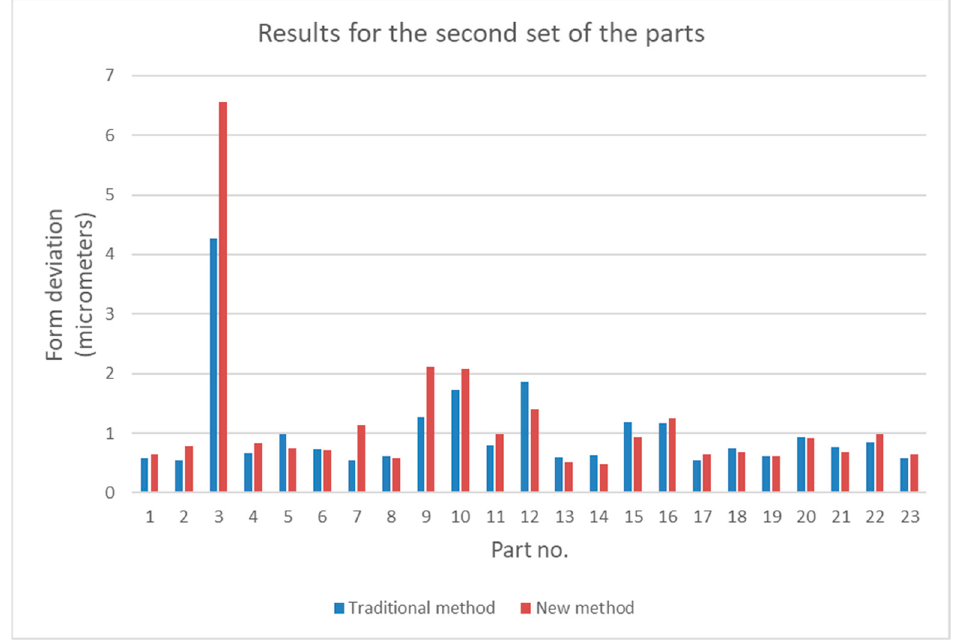
Figure 5. Comparison of form deviations obtained by the traditional and by the new method for the second set of parts.